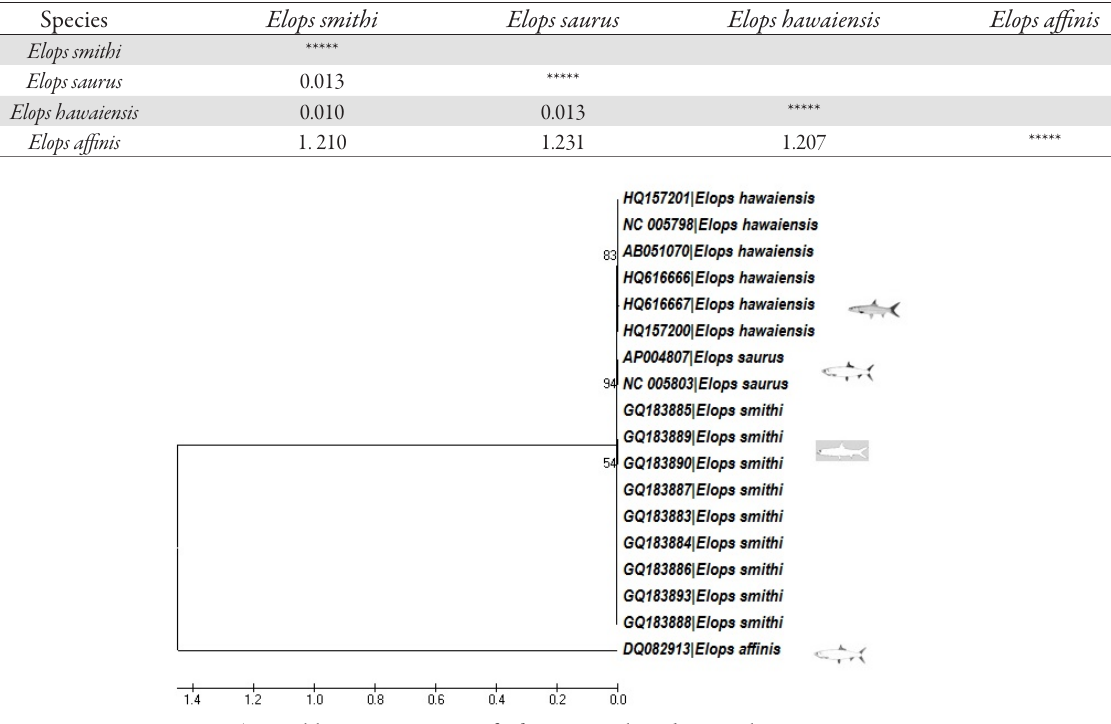
Fig. 4. Neighbour joining tree of Elops species based on Cytb gene